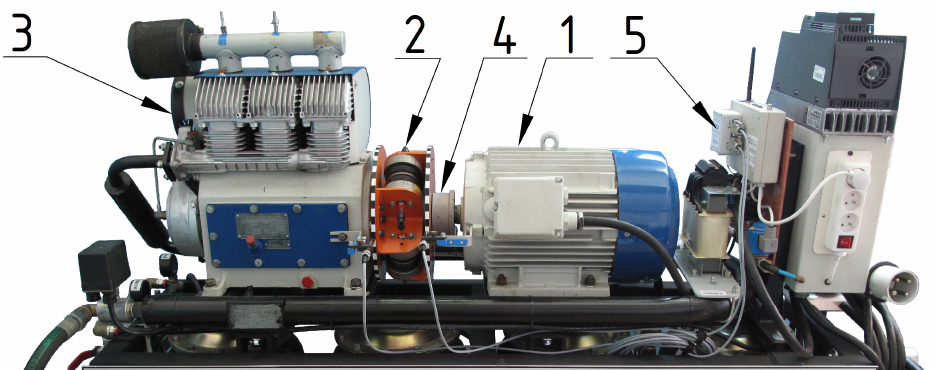
Figure 5. Experimental torsional oscillating mechanical